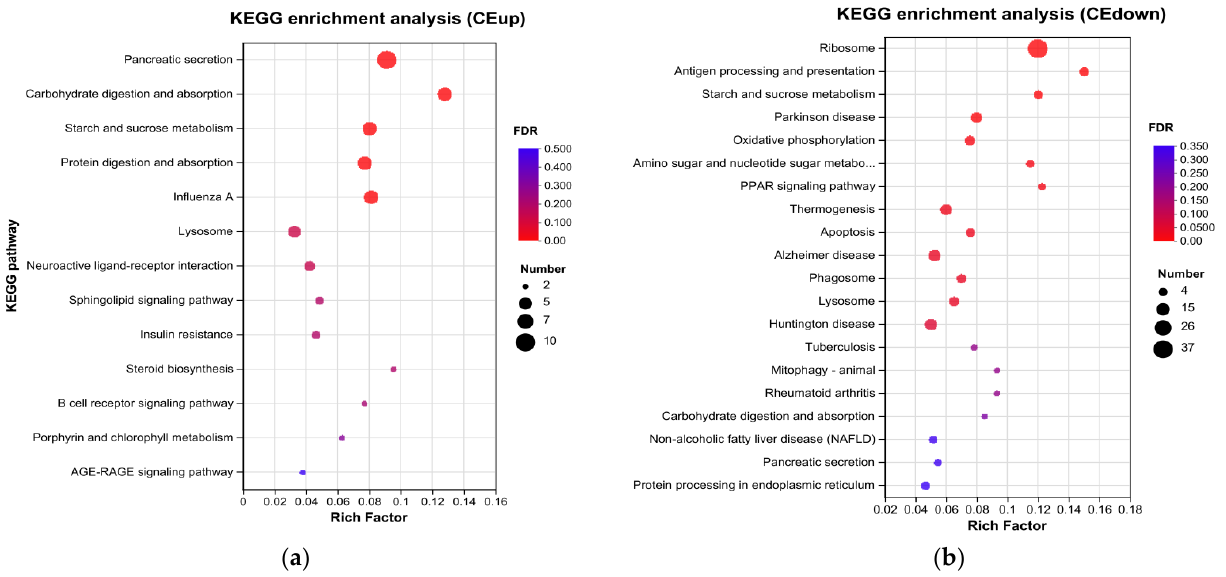
Figure 3. KEGG classification of significantly different proteins. ( a ) Upregulated pathway; ( b ) downregulated pathway.